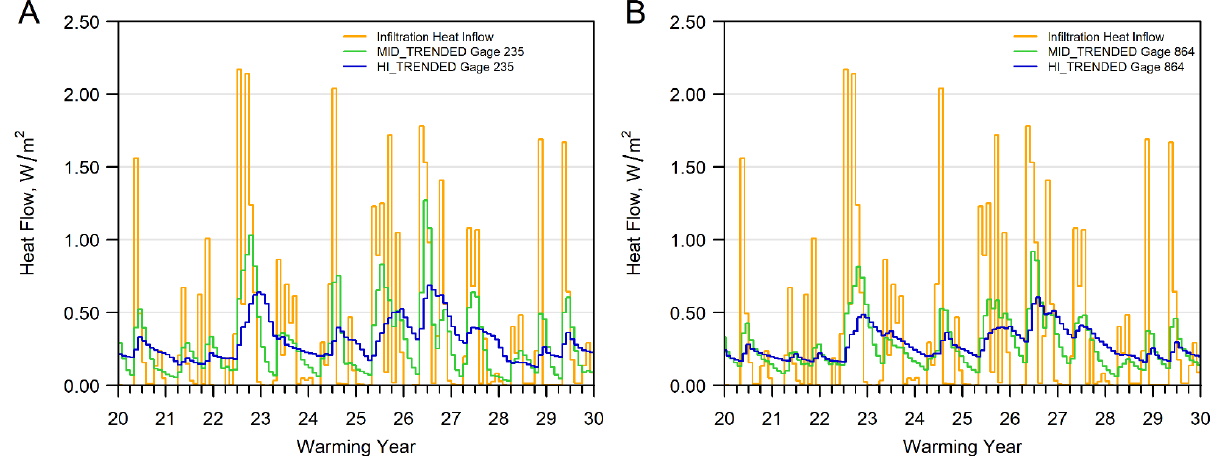
Figure 12. Heat flow response (Watts/m 2 ) along recharge pathway for ( A ) MID_TRENDED and ( B ) HI_TRENDED simulations. Graphs compare impulse heat flow in INFILTRATION to response heat flow in the pathway during last 10 years of warming for contributing basins corresponding to headwater gage (235) and model outlet gage (864). Heat Flow = Heat Flux over basin normalized by basin area.